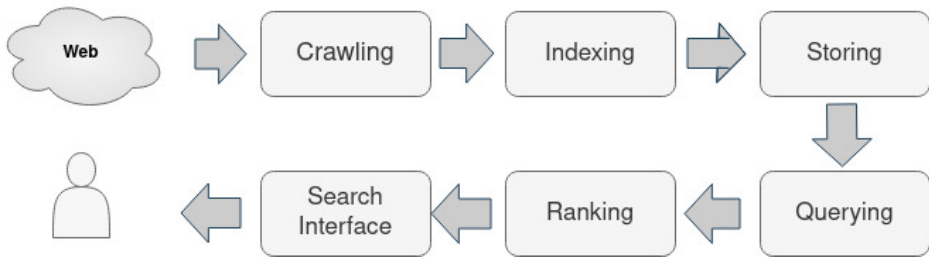
Figure 4. Semantic search engines process